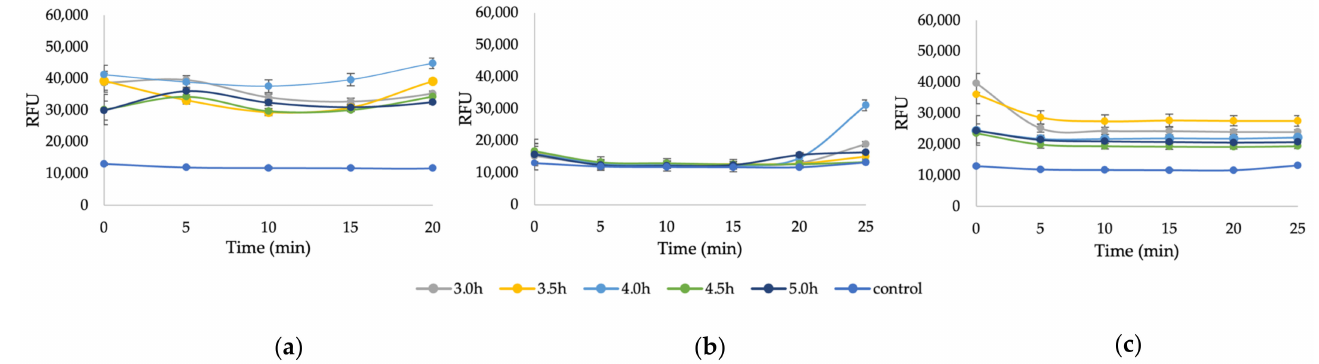
Figure 5. The RFU of Whatman filter paper after 3–5 h of 64% sulfuric acid hydrolysis at 45 ◦ C ( a ) be- fore centrifugation, ( b ) after one centrifugation (6000 rpm, 15 min), and ( c ) after two centrifugations (6000 rpm, 15 min); 0.4% KOH (pH = 13), 0.1% CFW.